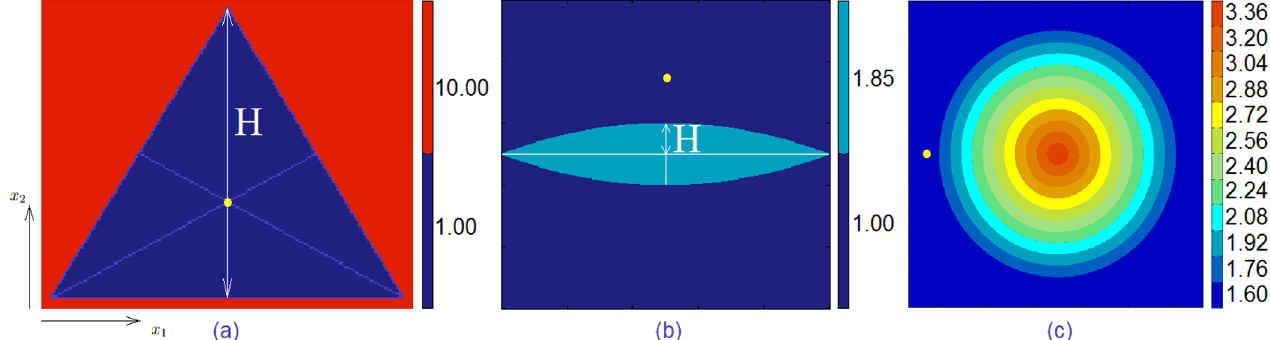
Fig. 1. Shapes of obstacles: (a) For each isosceles triangle, the point force (directed along the x 2 axis) is located at the center of gravity of the triangle and the density outside the triangle is ten times larger than inside the triangle. Moreover, starting from this equilateral ffiffiffi p triangle of base 20 cm, and a height H equal to 10 3 cm, we have built three isosceles triangles keeping always the same base of 20cm but increasing each time the height H as follows: four-thirds of H for the fi rst isosceles triangle, fi ve-thirds of H for the second isosceles triangle, and six-thirds of H for the last isosceles triangle. (b) A convex lens (of maximum half-width H ) with a point force (directed along the x 2 axis) above it. (c) A layered Luneburg lens (a disk surrounded by 10 concentric layers) with a point force (directed along x 1 ) on its left side. The density of disk, layers, and the surrounding medium, appears on the color scale (in units of 10 3 kg.m (cid:1)